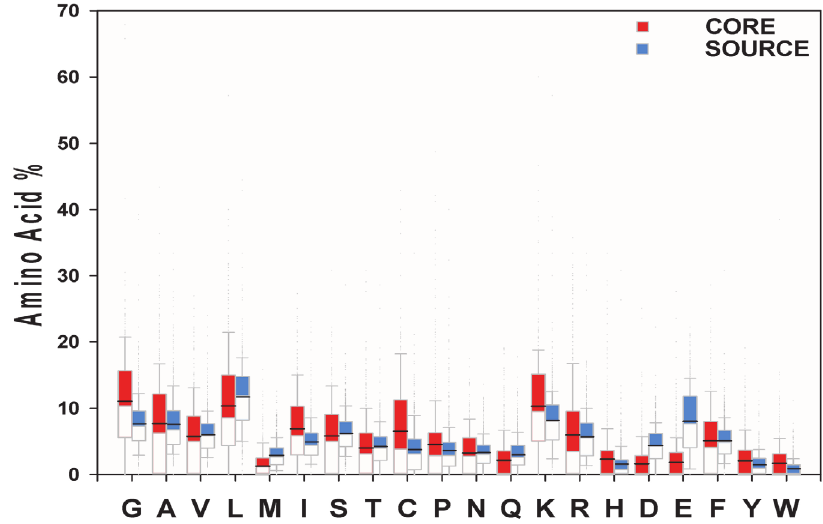
Fig 3. Statistical distribution of the amino acid composition of AMP critical regions and the background. The black line represents “ mean ” .